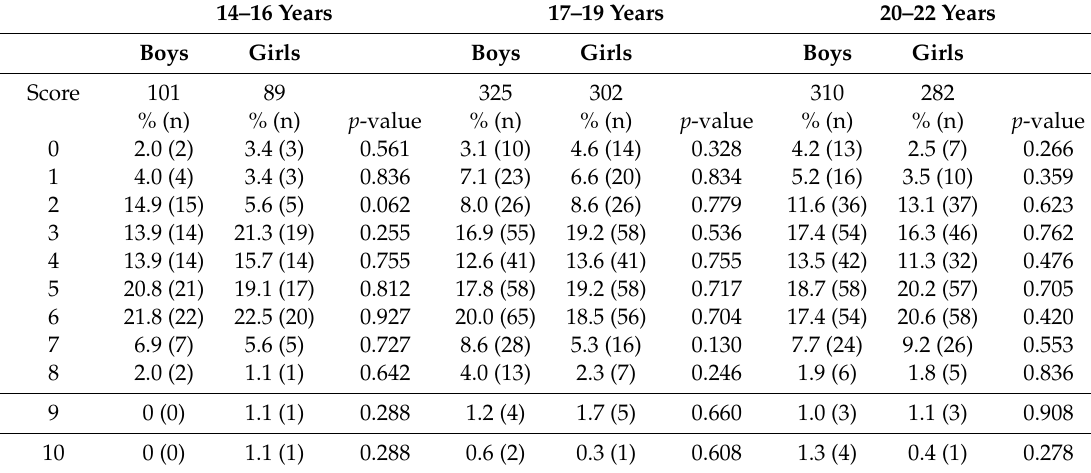
Table 5. The frequency and percentage frequency of the total score on perception of cardiovascular risk factors among Ellisras adolescents and young